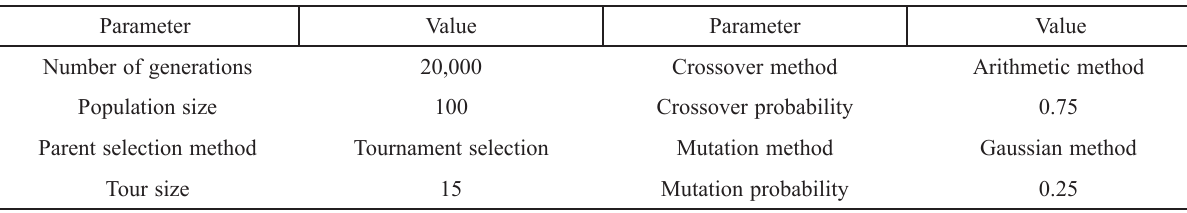
Table 2 – Properties of GA used in this study